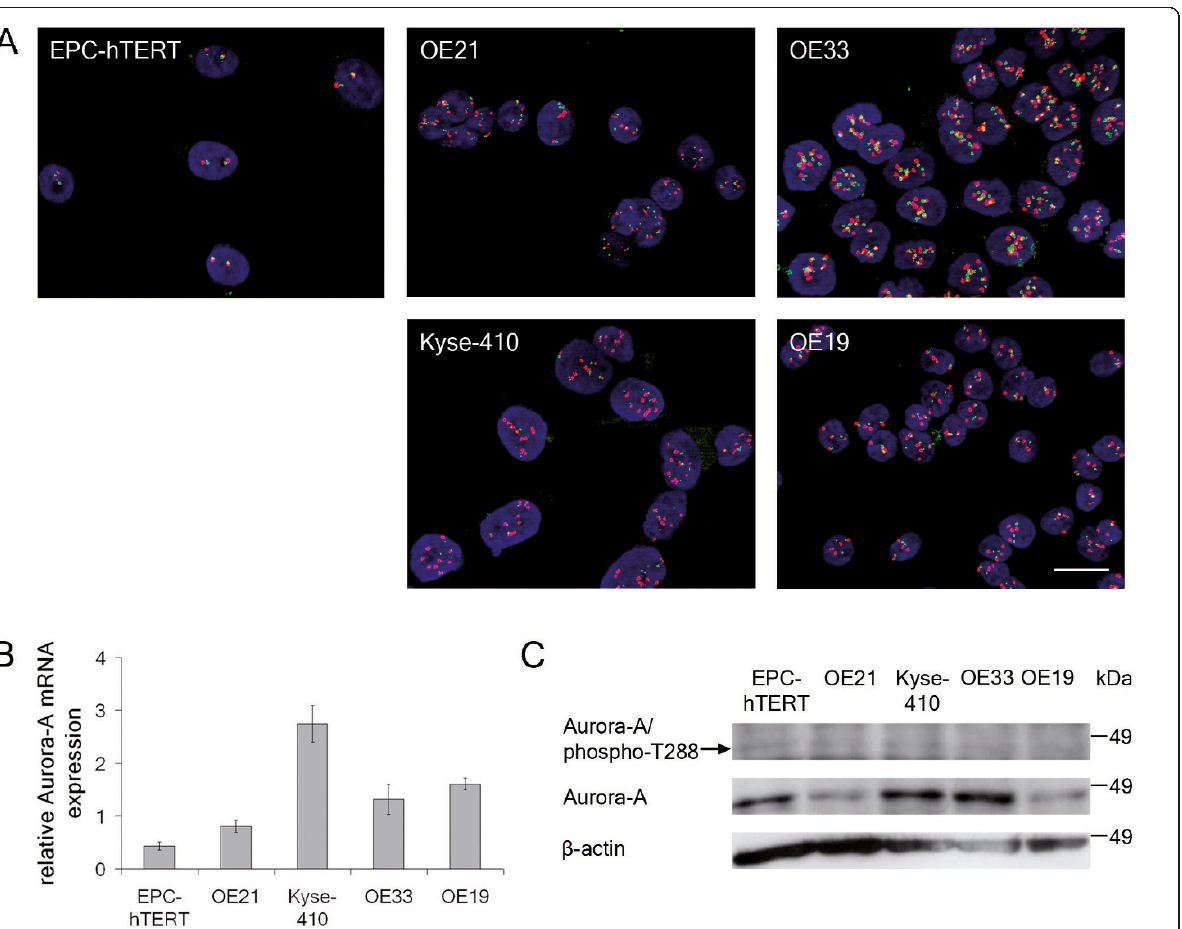
Figure 2 Aurora-A gene copy numbers, mRNA and protein expression in normal esophageal epithelial cells and esophageal cancer cells . A . FISH analysis of AURKA (red signals) and Chromosome 20 (CEP20; green signals). Bar = 20 μ m, all panels are in the same magnification. B . Relative Aurora-A mRNA expression was determined by qRT-PCR (mean ± standard deviation of three independent experiments). C . Photograph of Aurora-A/phospho-T288 and Aurora-A protein expression by immunoblot analysis, representative for 3 independent experiments. b -Actin served as loading